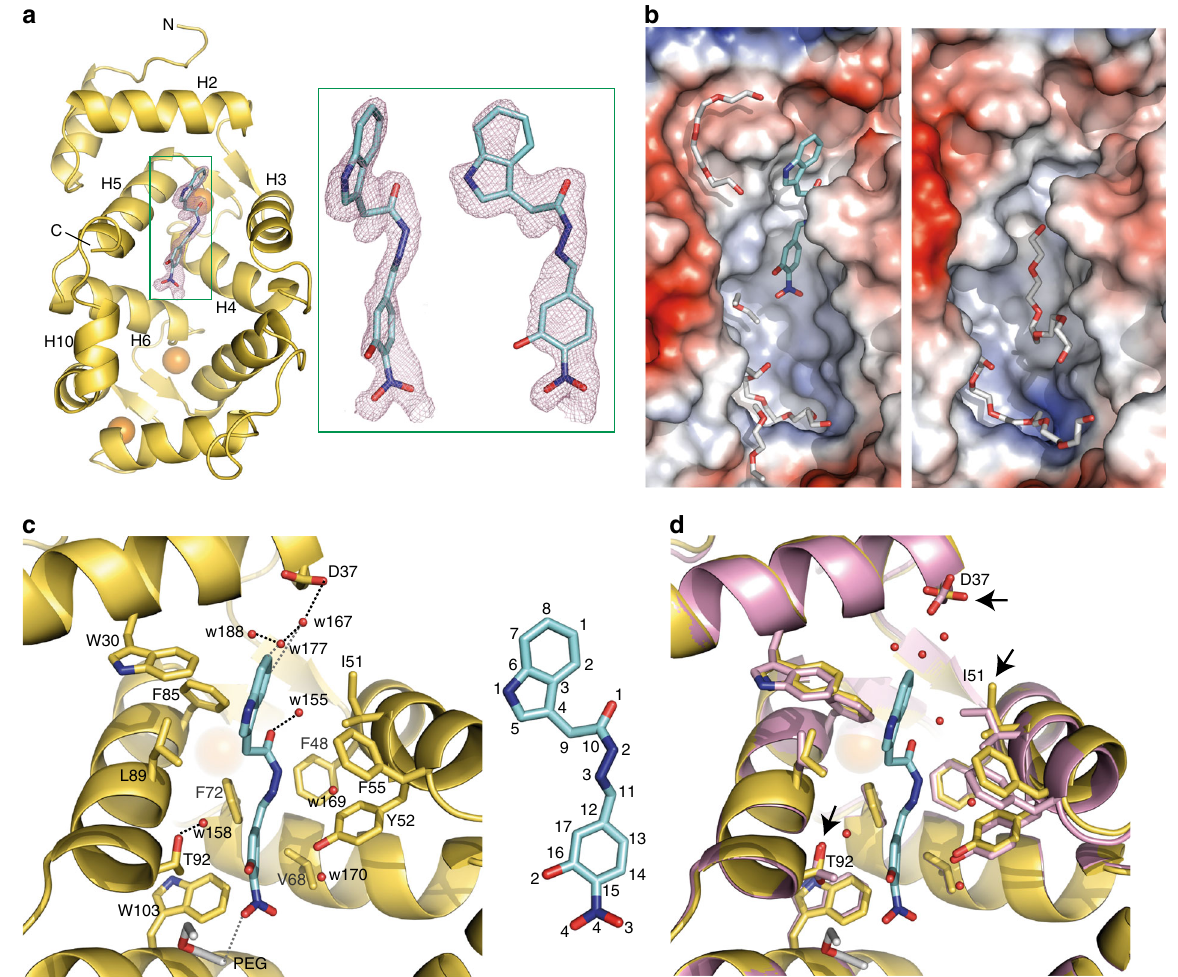
Fig. 7 Structure of the Ca 2 + bound h NCS-1/ 3b complex. a Ribbon representation of h NCS-1 bound to Ca 2 + (orange spheres) and 3b (cyan sticks). The calculated feature-enhanced map at the 3b region is depicted in pink at 1.4 σ level, and two zoomed-in views are shown (green square). b Electrostatic potential molecular surface representation of the two independent h NCS-1 molecules found in the AU showing the PEG content of the hydrophobic crevices (light grey sticks) and 3b . c Detailed view of the residues (side chains as yellow sticks) and molecules recognizing 3b . Strong and weak H-bonds are shown as black and grey dashed lines, respectively. 3b atom numbering is represented. d The superimposition of the ligand-bound (yellow) and the ligand-free (pink) h NCS-1 molecules found in the AU. Arrows indicate the residues that suffer important